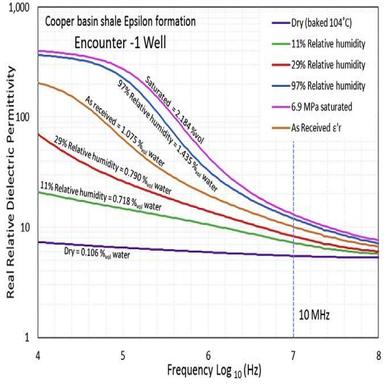
Dielectric response normal to bedding, of a typical silty shale sample from the Epsilon Formation from Encounter-1 well in the Cooper Basin, South Australia. A strong increase in dielectric permittivity and dispersion results from as little as 2% water by volume.